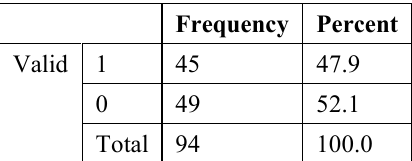
Table 2. Frequency for the Variable Innovation